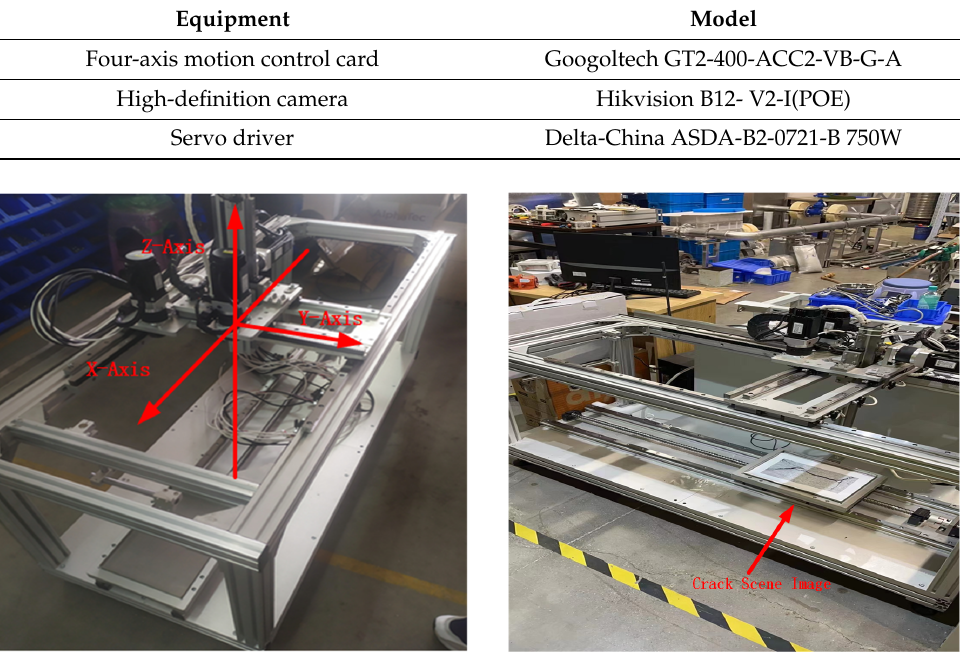
Table 3. Prototype equipment parameter.